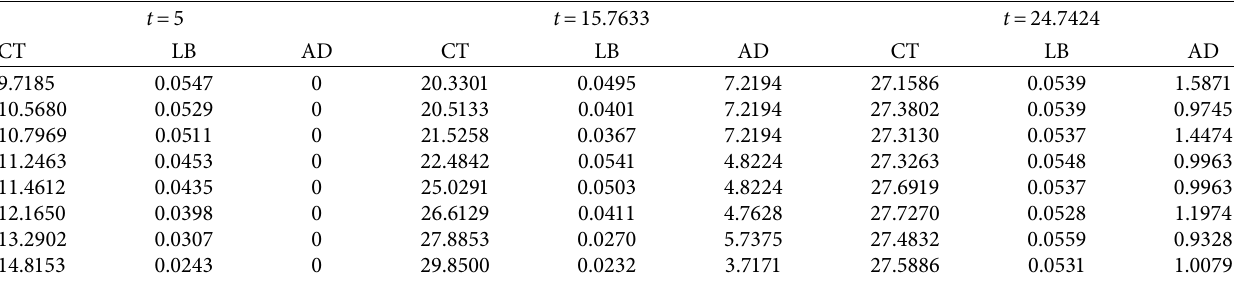
Table 3: Nondominated solutions retained at different